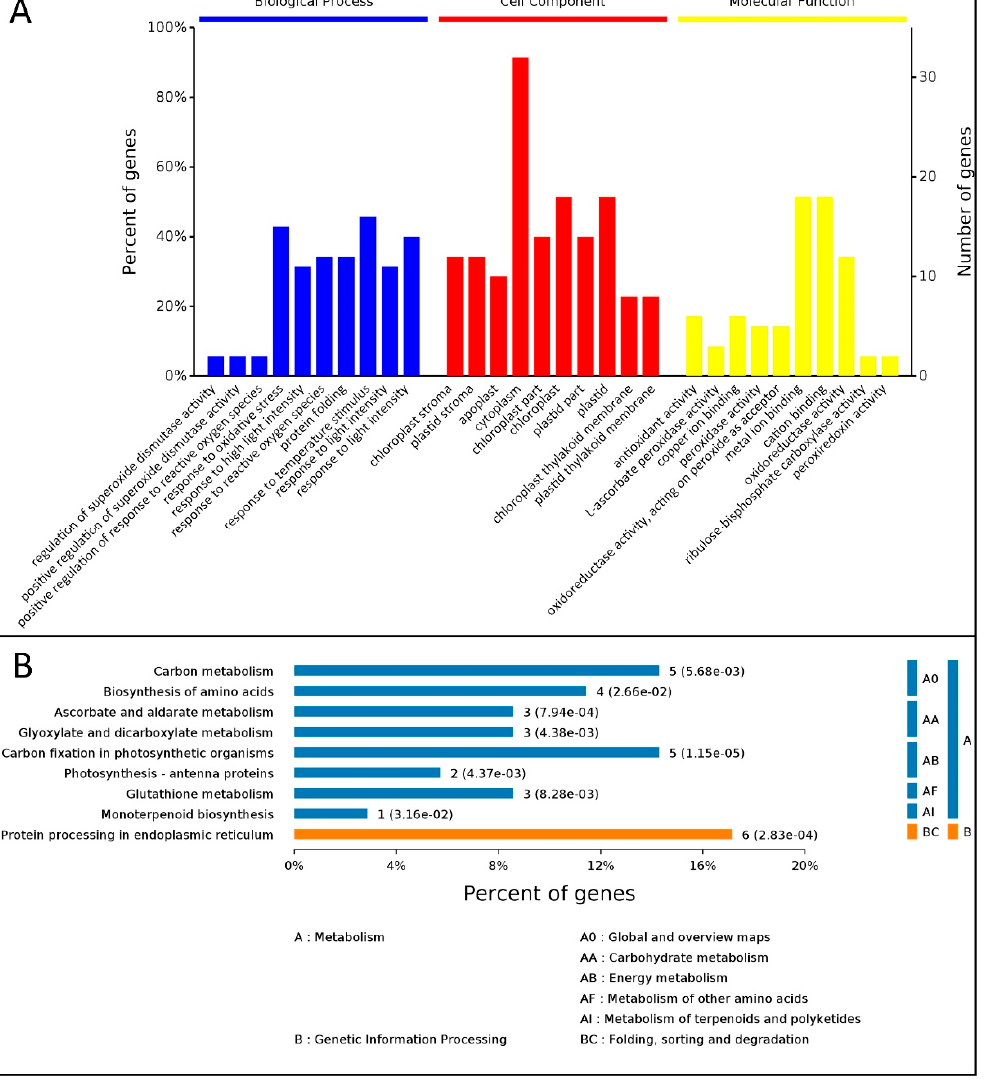
Figure 4. The function classification of GO ( A ) and KEGG pathway annotation ( B ) in M . ‘Prairifire’ leaves after 38 °C heat shock for 48 h.